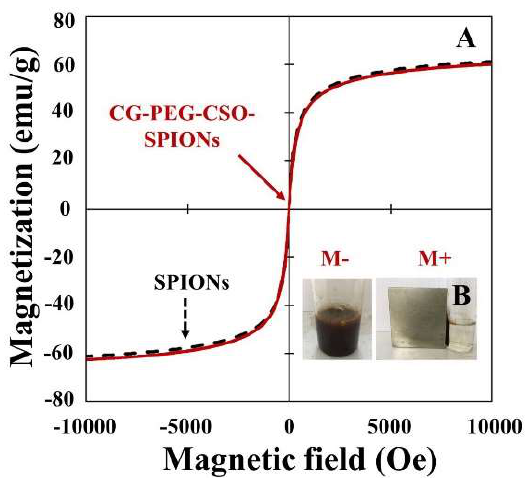
Figure 6. Representative XRD patterns of SPIONs, PEG-CSO-SPIONs; CG powder, and CG-PEG-CSO-SPIONs.